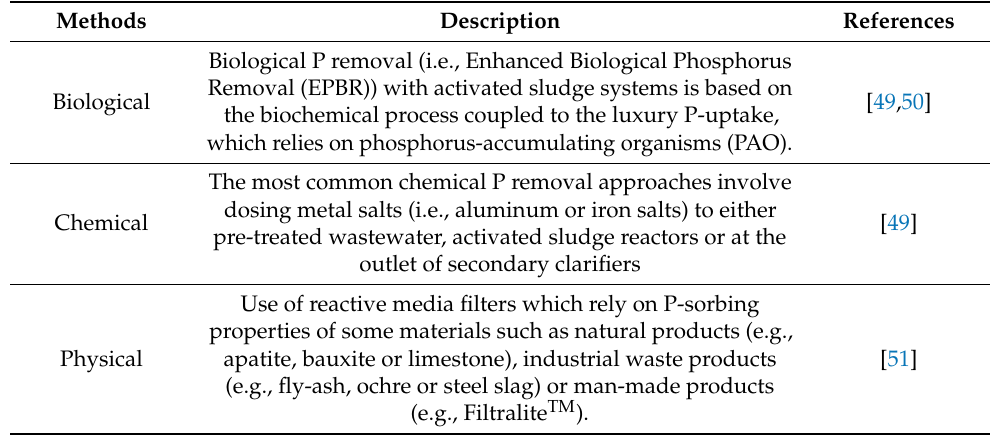
Table 2. Overview of the main P-removing